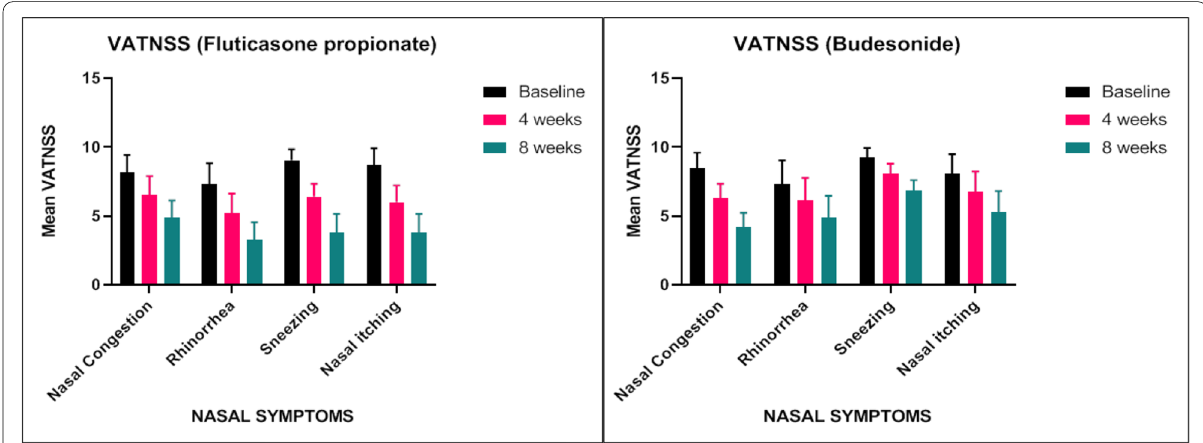
Fig. 2 A Comparison of total nasal symptoms scores at baseline, 4th and 8th week in patients treated with Fluticasone propionate. B Comparison of total nasal symptoms scores at baseline, 4th and 8th week in patients treated with